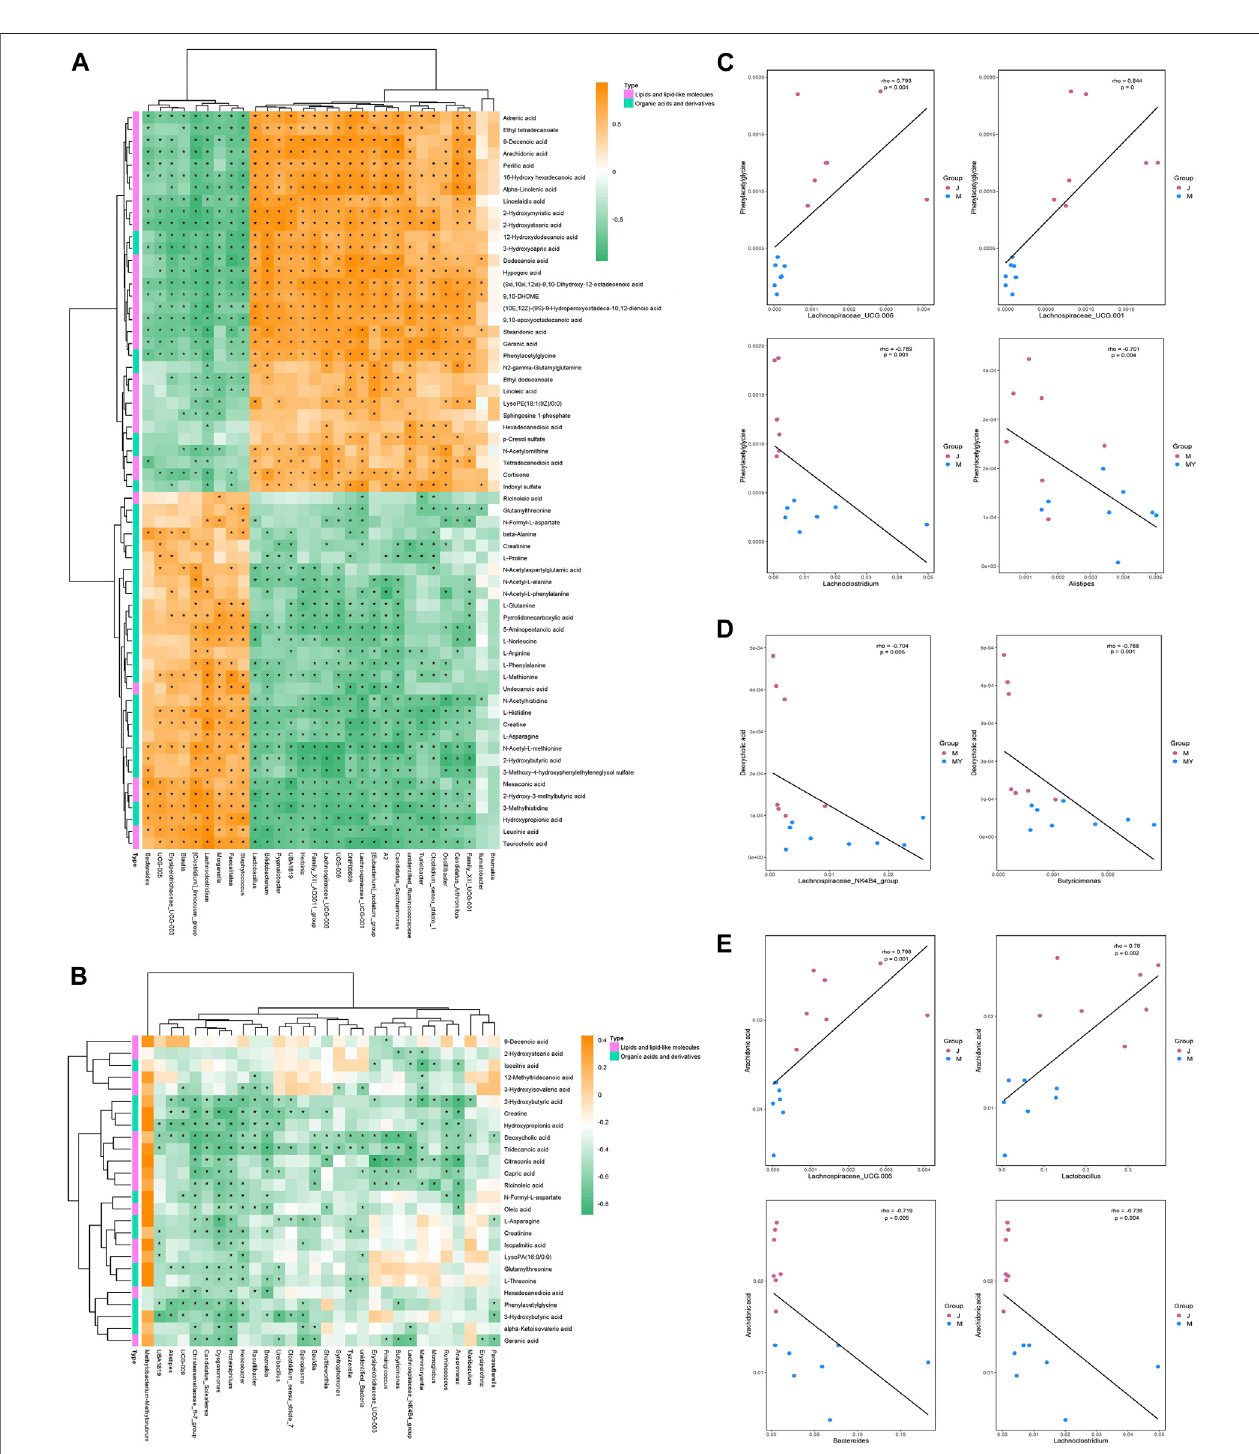
FIGURE 6 | Thecorrelationbetween gutmicrobiotaand metabolitesindevelopmentand outcomeofstroke. (A) HeatmapofSpearmancorrelationsbetweenthebacteria whoseabundancessigni fi cantlychangedinmodel( n (cid:1) 8)VSsham( n (cid:1) 7)groupandthe2typeofmetabolites(lipidsandlipid-likemoleculesandorganicacidsandderivatives)with important functions and signi fi cant differences. The color bar with numbers indicates the correlation coef fi cients; (B) Heatmap of Spearman correlations between the discrepant bacteria in model ( n (cid:1) 8) VS NMT ( n (cid:1) 8) group and the 2 type of metabolites; (C) Relationship between intestinal L-asparagine level and Lachnospiraceae_UCG.001 and Lachnoclostridium whose abundances signi fi cantly changed in model rats. rho: the spearman correlation coef fi cient; p: statistical signi fi cance. p < 0.05 and |rho| > 0.7; (D) Relationship between intestinal Indoleacetaldehyde level and the four most changed abundant bacterial genera; (E) Relationship between intestinal 2-Hydroxybutyric acid and Creatinine level and the most changed abundant bacterial genera.